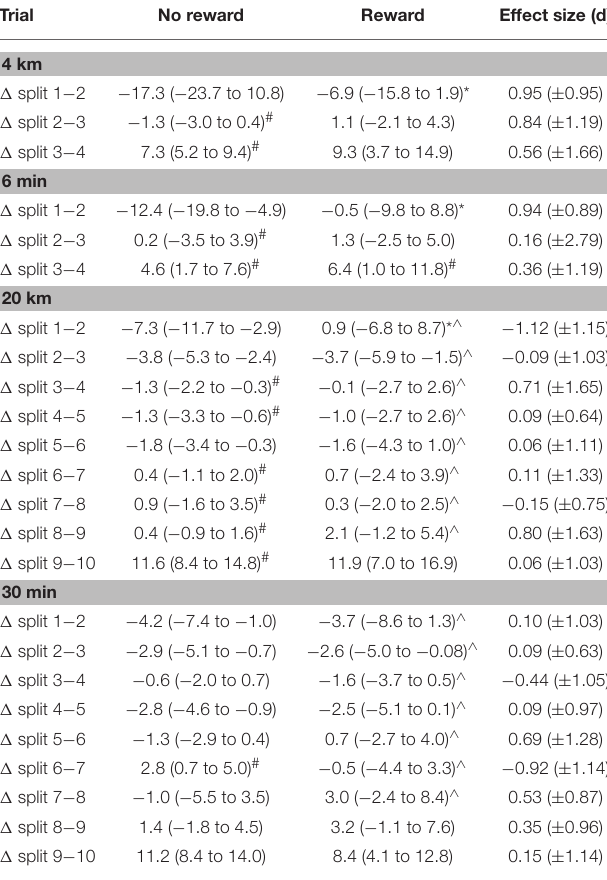
TABLE 3 | Mean split change ( 1 ) of power output between splits.